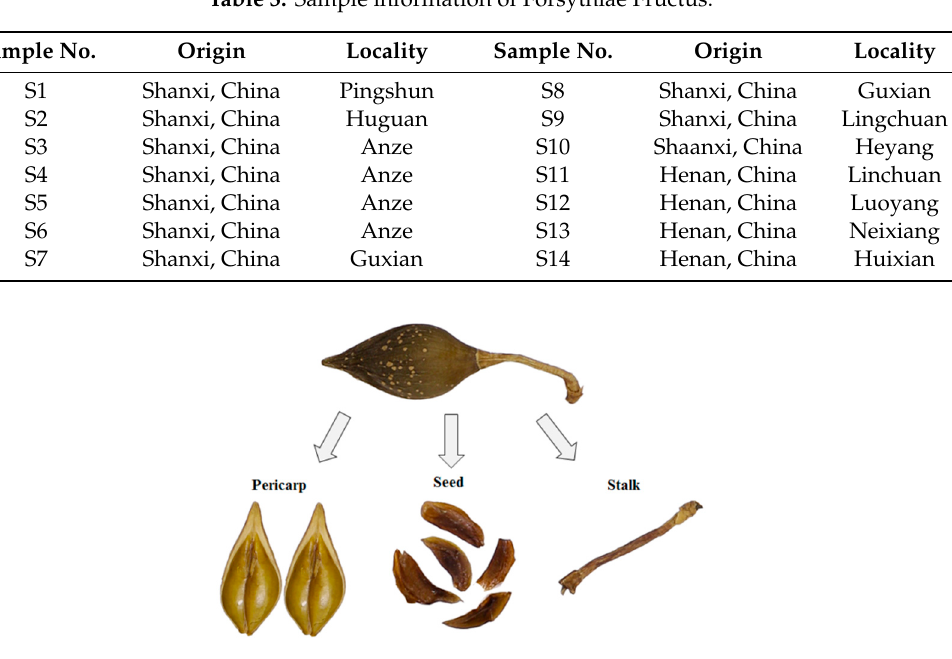
Figure 4. Three segments (pericarp, stalk and seed) of Forsythiae Fructus.